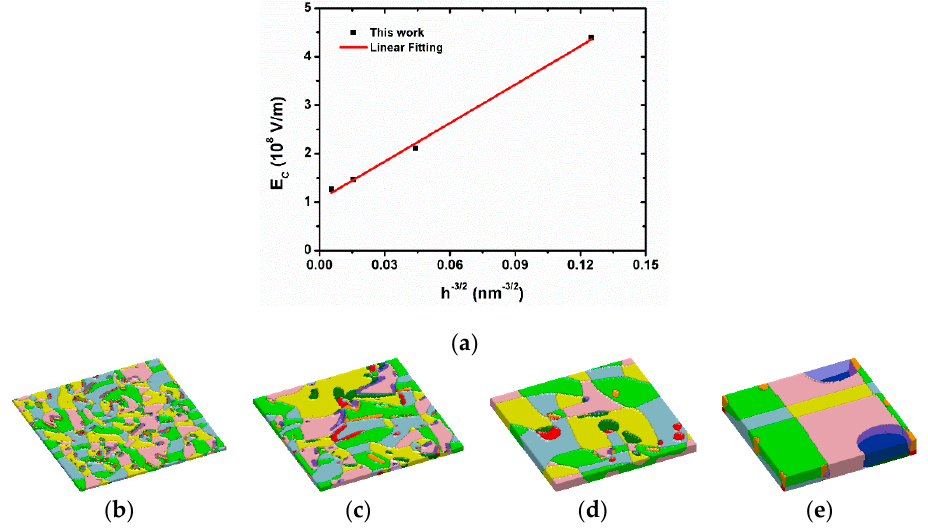
Figure 5. ( a ) Calculated coercive field E c plotted against film thickness h . Calculated domain configurations near the value of coercive field for films of ( b ) 4 nm, ( c ) 8 nm, ( d ) 16 nm, and ( e ) 32 nm.